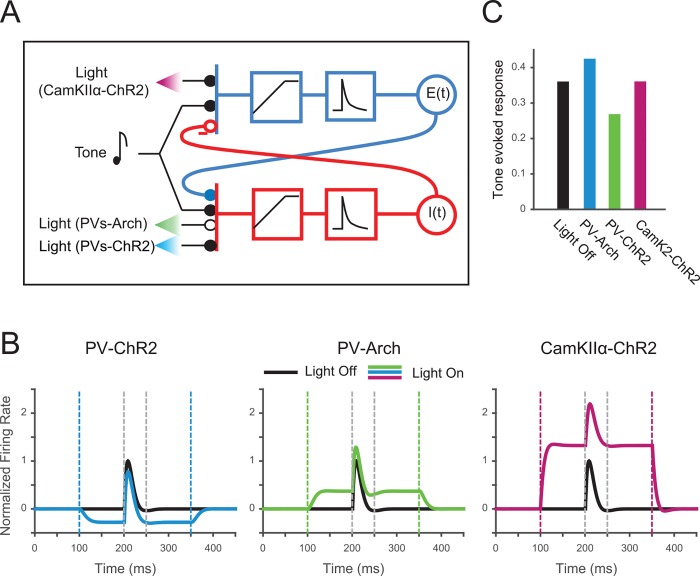
Mutually coupled excitatory–inhibitory neuronal model accounts for differential effects of PV and excitatory neuronal modulation on tone-evoked response magnitude.A. Diagram of model of inhibitory and excitatory mutually coupled neuronal populations. Closed circles: excitatory inputs; open circles: inhibitory inputs; -: depressing synapse. Blue boxes: excitatory pathway. Red boxes: inhibitory pathway. B. Tone-evoked responses of model neuronal excitatory population under different optogenetic manipulations. Tone is from 200 to 250 ms. Left: ChR2 in inhibitory neurons. Center: Arch in inhibitory neurons. Right: ChR2 in excitatory neurons. Black trace: Light-off condition; Color trace: Light-on condition. See matlab code in S1 Model. C. Mean magnitude of tone-evoked responses under different stimulation conditions.